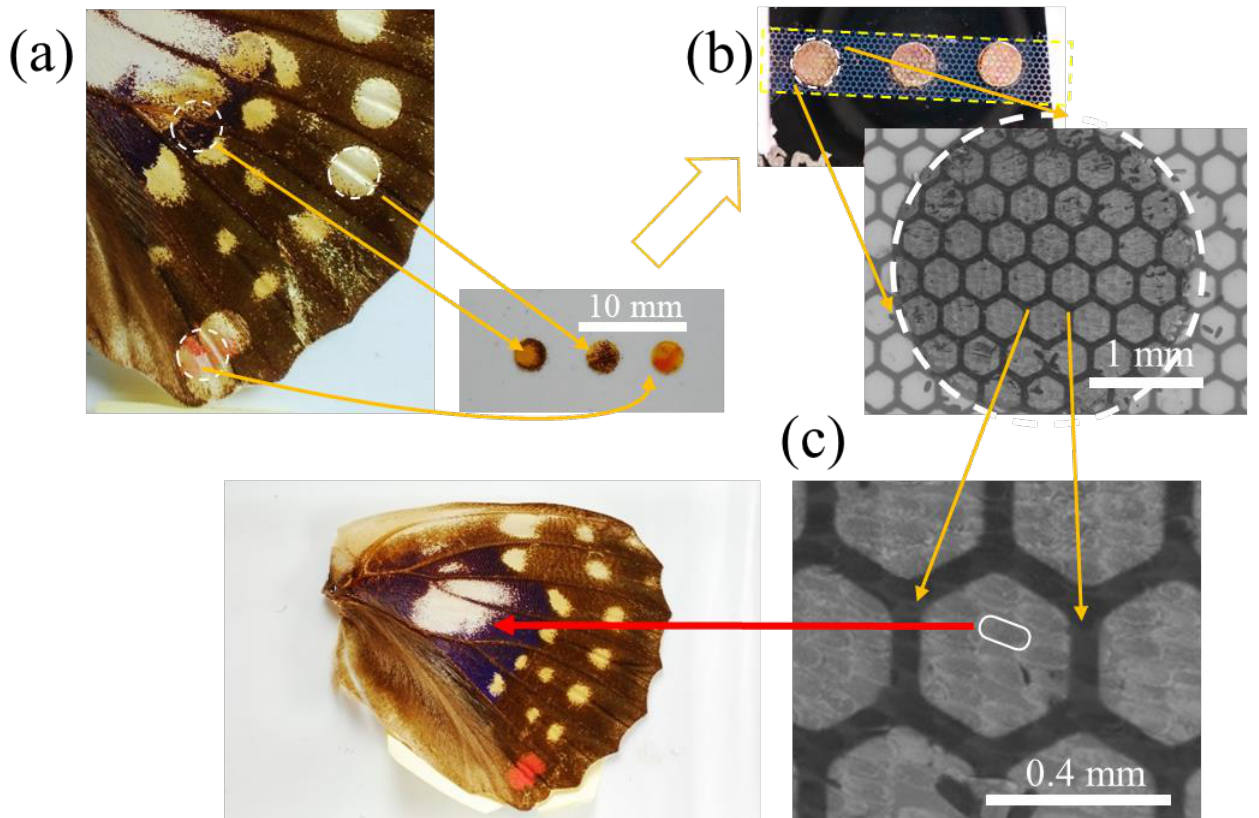
Figure 1. The protocol for cataloging individual scales. ( a ) Circular specimens excised from a wing of S. charonda . ( b ) Excised specimen transferred onto a glass slide and silver deposited through a metal mesh. ( c ) Individual scales traceable to initial locations within the wing. Scale bars: ( a ) 10 mm, ( b ) 1 mm and ( c ) 0.4 mm.